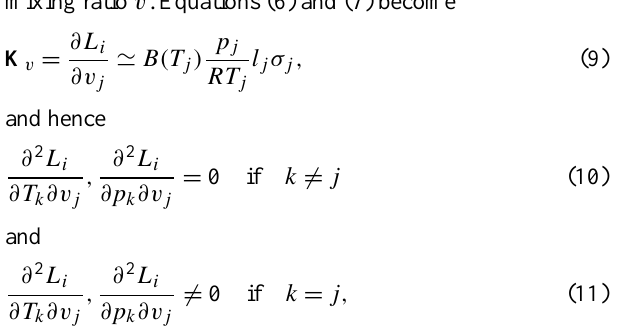
Fig. 8. CH 4 variation about a Global, 60 ◦ , 30 ◦ and 20 ◦ latitude bin profiles for the MIPAS MA mode days available in June, July and August for 2007, 2008 and 2009. 33